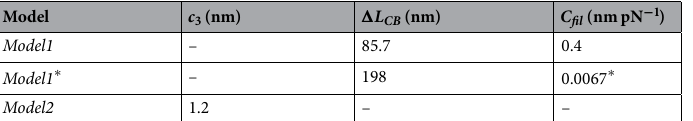
c 3 ) in the Table 2. Parameter estimations. In model2 , the parameter c 3 represents the pole (at L CB = − non-linear cross-bridge force–length relation F CB ( L CB ) (Coulomb drive in series to the serial elastic part representing S1, S2 and filaments), which is used to estimate k CB , and eventually k hs . In model1 , the parameter (cid:31) L CB (nm) represents the average elongation at a fixed force of each cross-bridge acting in series to the filament part with compliance C fil . The parameter values of both model1 and model2 were determined with the Matlab curve fitting tool ‘cftool’. If the maximum isometric force of a half-sarcomere F CB , max is 445 pN, as estimated in 15 ) 1.56nm and C fil 1.77 nm T − 1 this paper, then the original parameter values for model1 ([ (cid:31) L CB 0 ] = = 251 pN nm − 1 ( 445 pN 285 pN nm − 1 ( 445 pN k fil F CB , max . ∗ (cid:31) L CB (nm) would translate to k CB 1.56 nm ) and 1.77 nm ) at = =